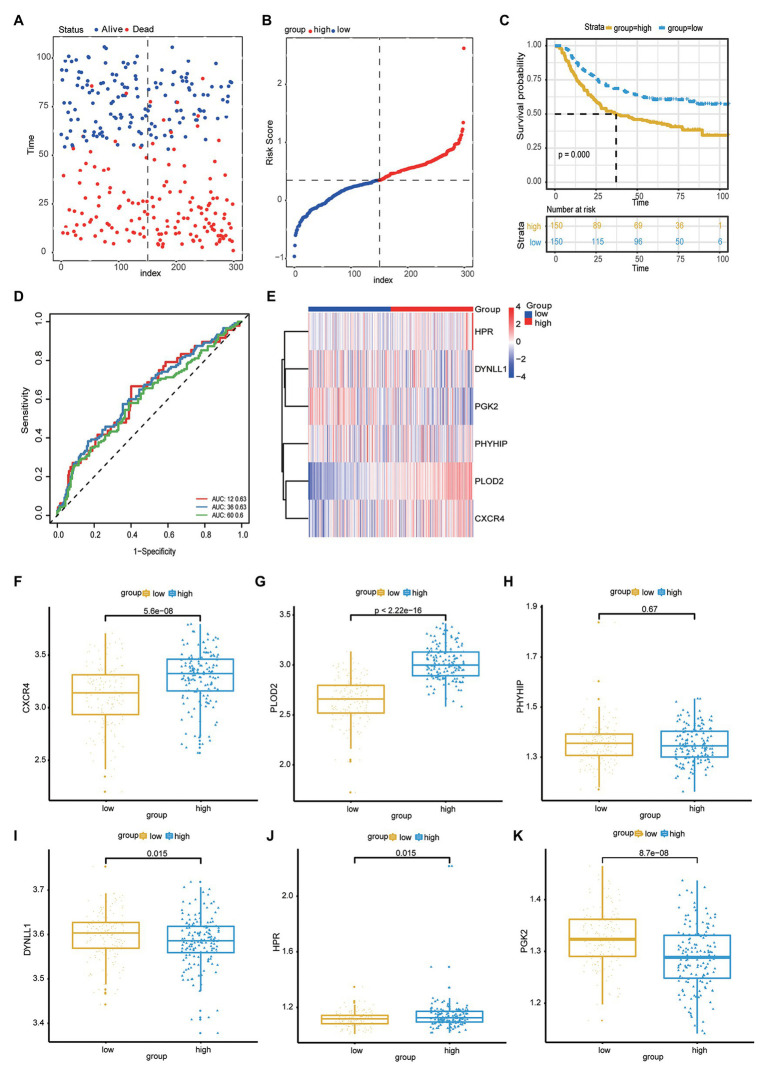
(A) Scatter plot shows the survival status of GC patients. (B) Risk score distribution of high- and low-risk group. (C) The Kaplan-Meier plot of the risk score model to show the for the GC prognostic status. (D) The ROC curves of risk score model for the prognostic accuracy of GC patients in one-year, three-years and five-years. (E) Heat map shows the expression of autophagy-related genes in the high risk score group and low risk score group. (F-K) Boxplot to show the expression of CXCR4, PLOD2, PHYHIP, DYNLL1, HPR, PGK2 in the high- and low-risk group.